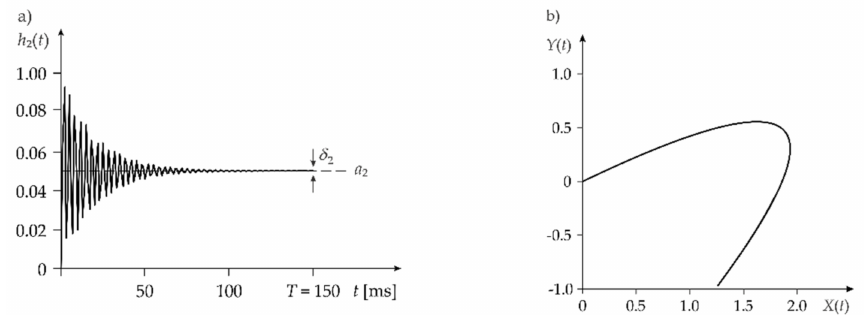
Figure 7. Example characteristics for the BLDC machine: ( a ) step response; ( b )